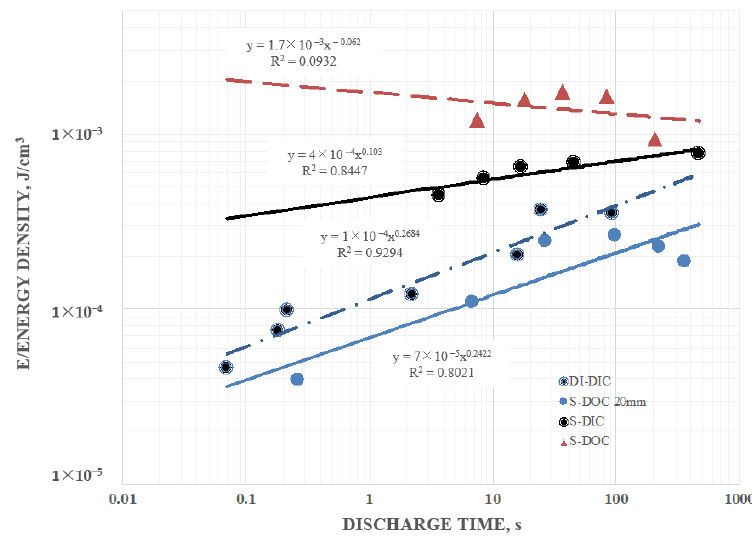
Figure 7. Energy density 6 mm capacitor—the 6 mm capacitor consistently had higher energy density than the 20 mm capacitor in all equivalent configurations. Parameters: ±10 V and holding for 200 s at ±10 V. Note: For the two “DOC” configurations shown the energy density was the effective energy density.